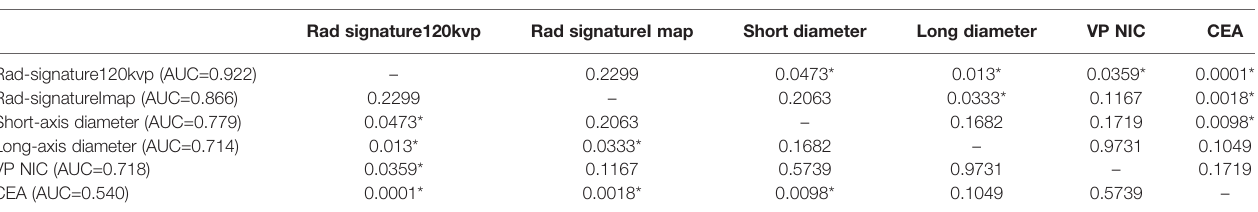
TABLE 6 | P -values of DeLong test for AUC of 6 different signatures or indicators.